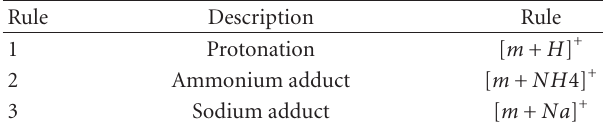
Table 3: List of adduct rules for correction of data measured in positive ionization